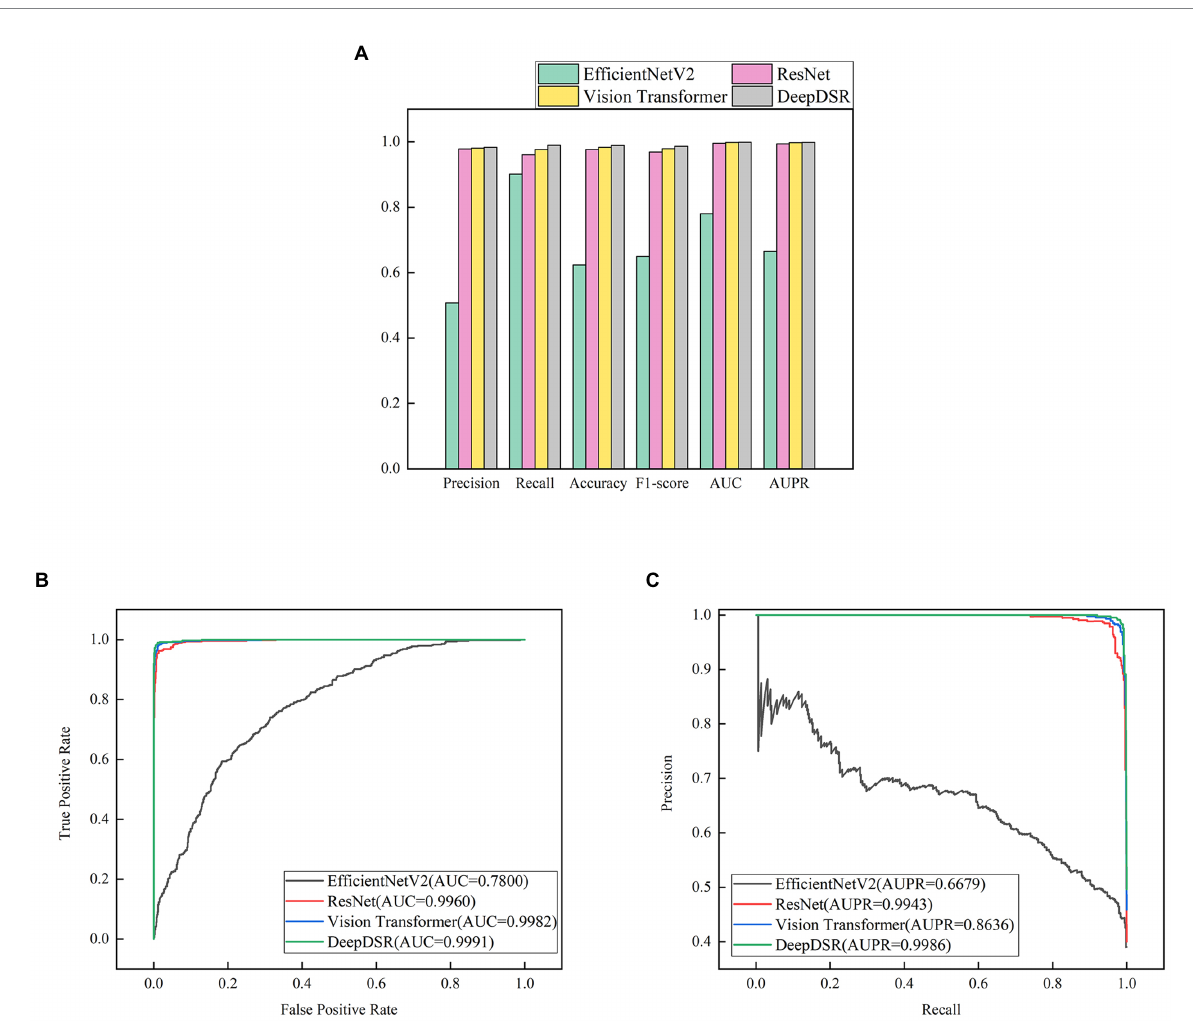
FIGURE 4 (A) The performance comparison of DeepDSR and other models for COVID-19 image binary classification. (B,C) The AUC and AUPR values of DeepDSR and other models for COVID-19 image binary